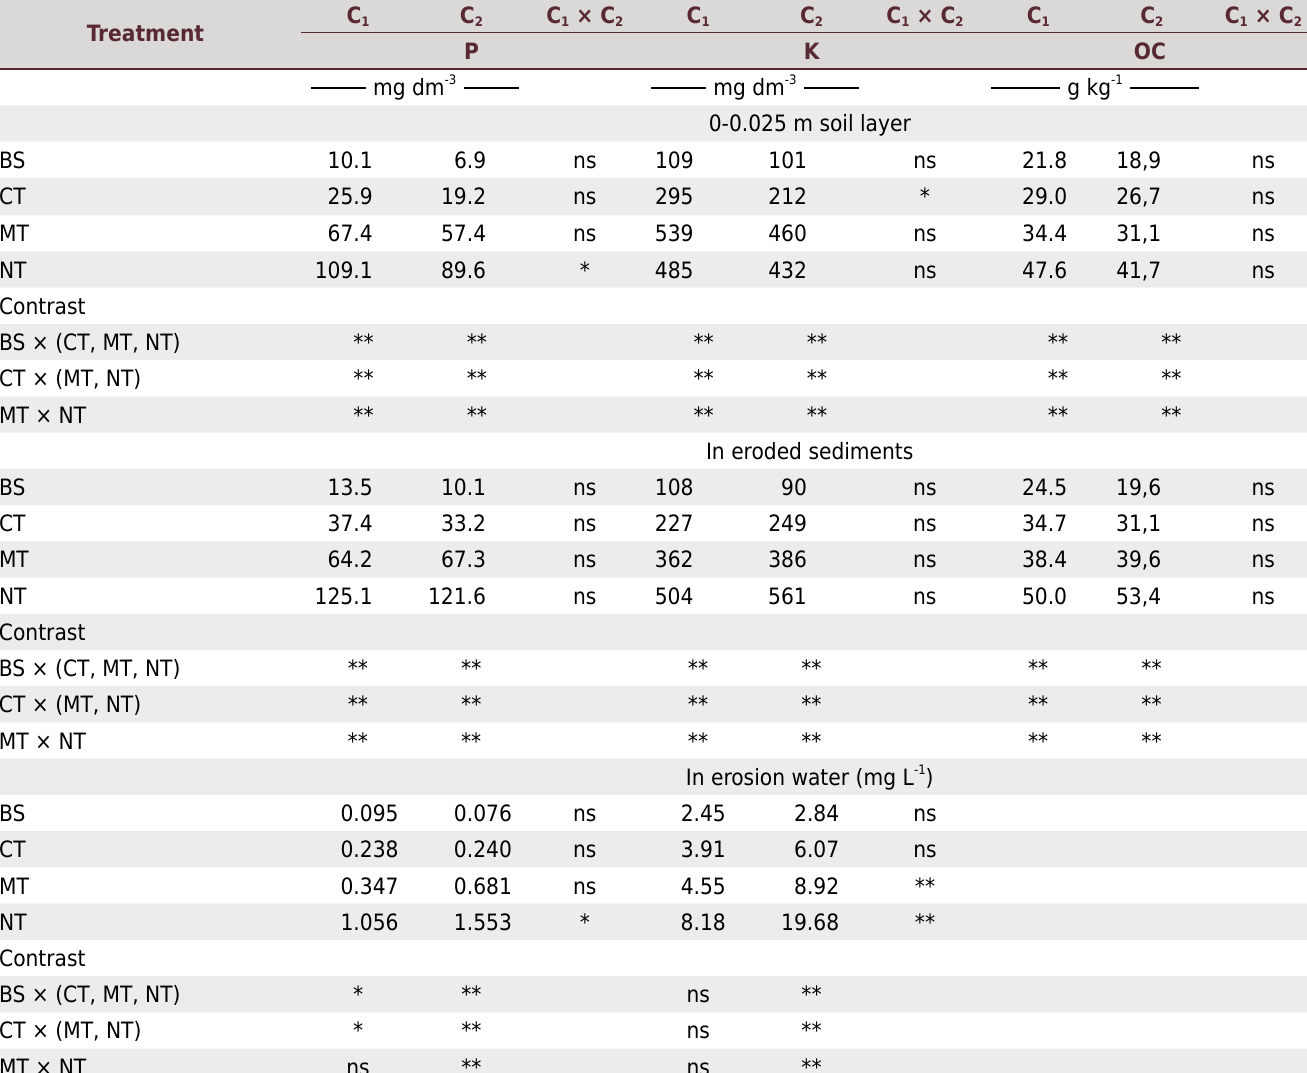
Table 1. Contents of extractable phosphorus, exchangeable potassium, and organic carbon (OC) in the 0-0.025 m layer of the soil in the sediments and water of erosion under natural rainfall, in a Humic Cambisol under different systems of use, management, and tillage of the soil (average of 15 years)